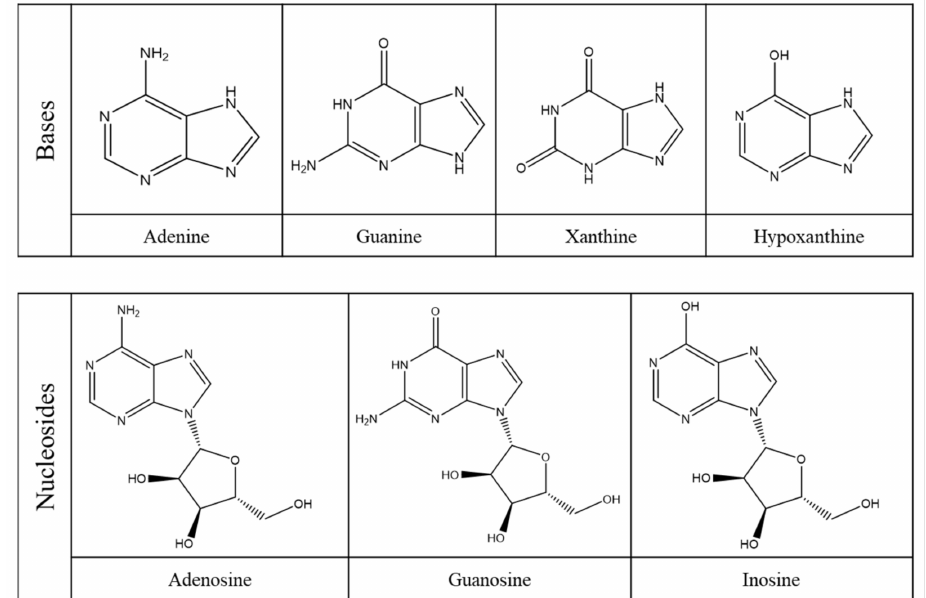
Figure 6. Most common purine nucleosides and bases found in